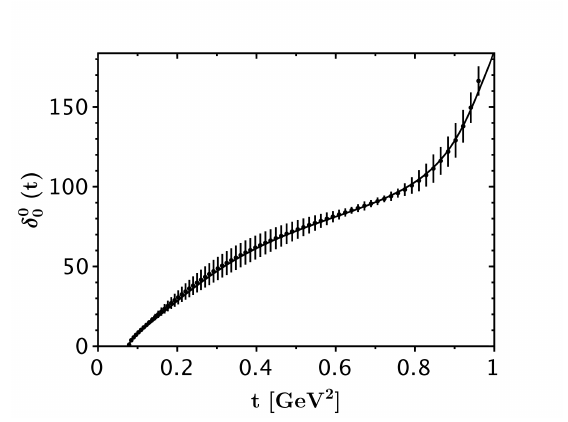
Figure 1. The data on δ 0 ( t ) with theoretical errors to be generated by GKPY equations for the S- 0 wave isoscalar ππ scattering amplitude. Solid line represents our optimal fit of data with 5 nonzero coe ffi cients A i in